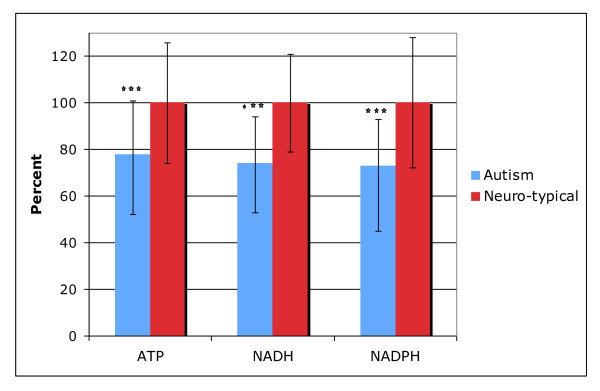
ATP, NADH, and NAHPH were significantly different between the autism and neurotypical groups. The average values and the standard deviations are shown, rescaled to the average neurotypical value. The number of asterisks indicates the p-value (* p < 0.05, ** p < 0.01, *** p < 0.001).